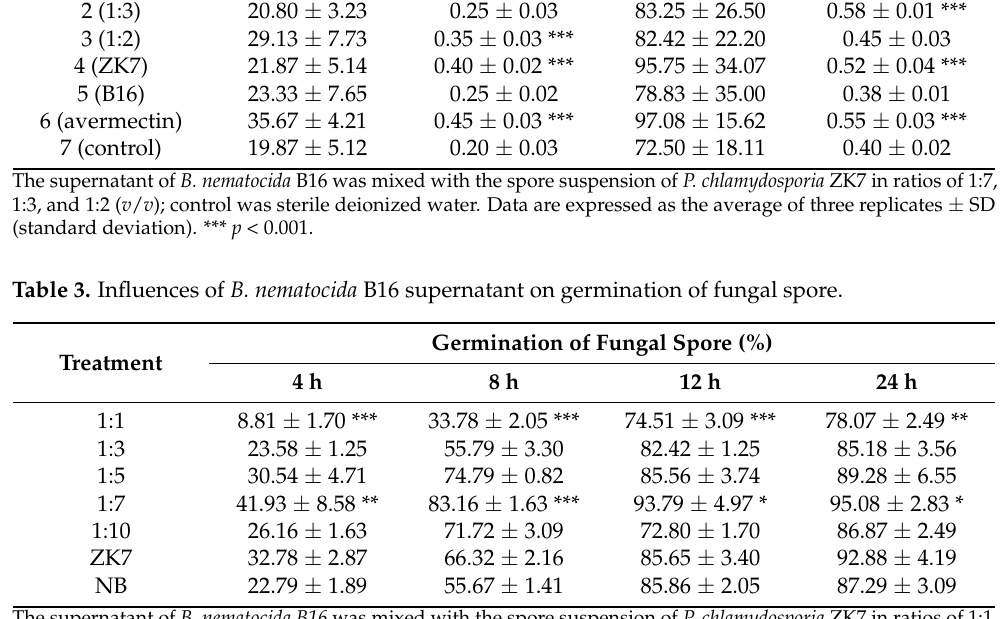
Table 2. Effects of different treatments on plant height and fresh weight of tomato (conducted in field experiments). 30 Days 60 Days Treatment Plant Height Fresh Weight Plant Height Fresh Weight